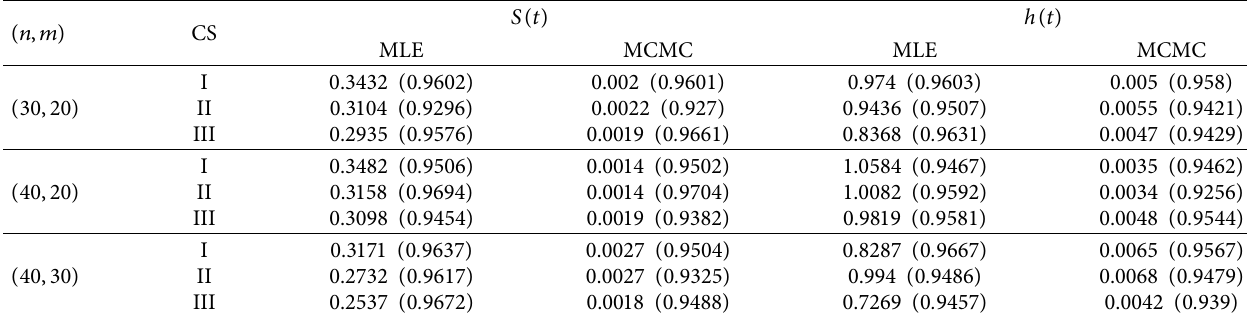
Table 10: ACL and CP of 95% CIs for the parameters S ( t ) and h ( t )